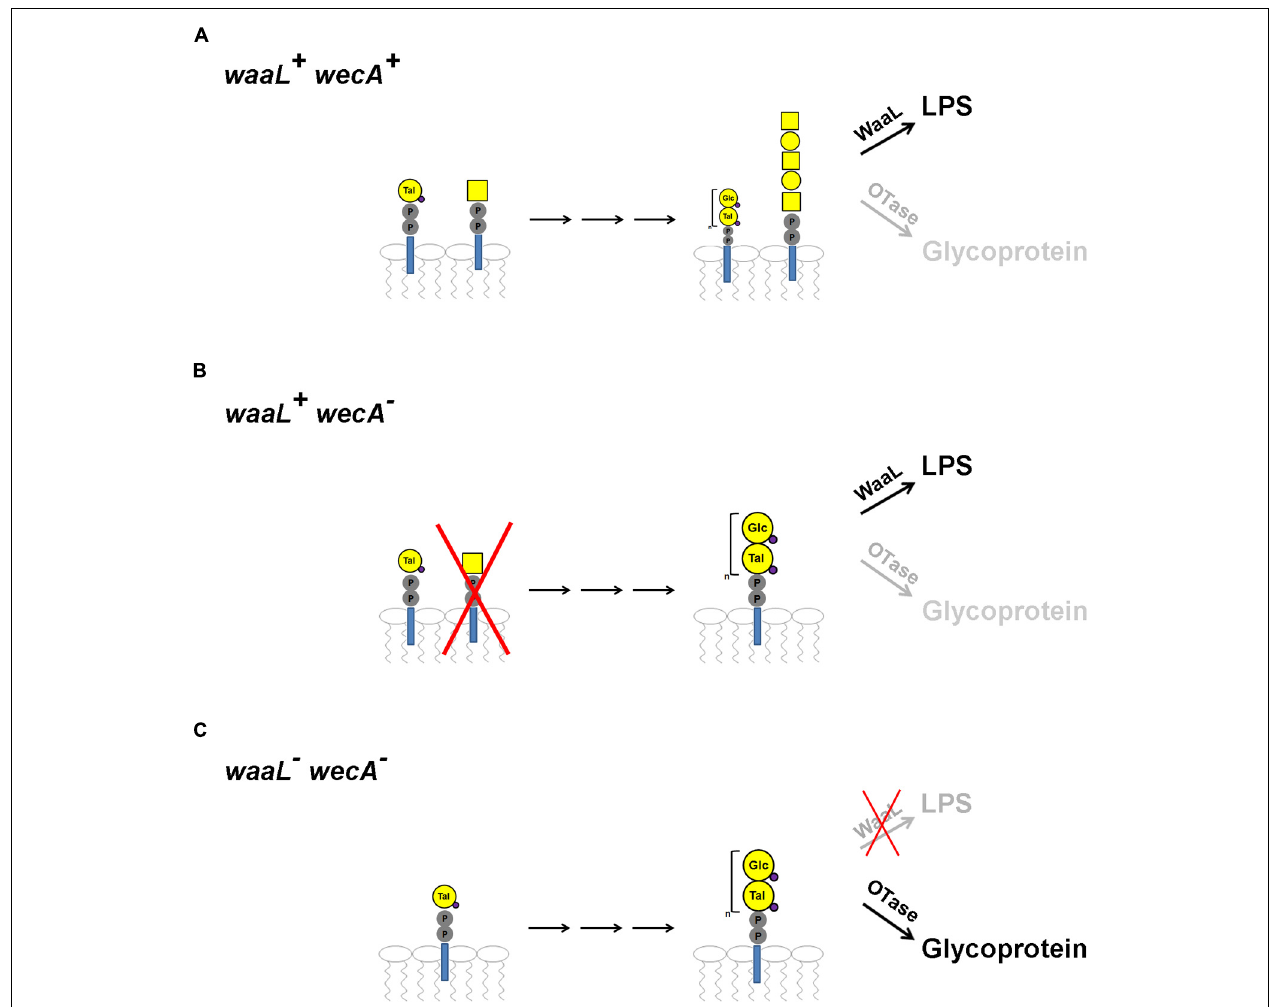
protein by PglB (OTase). (B) If wecA is deleted, the native O-antigen cannot be produced, allowing for a greater production of OPS II. However, OPS II would be still selectively transferred byWaaL over PglB. (C) If both wecA and waaL are deleted, the OPS II structure would be highly produced, and only available to PglB for synthesis of